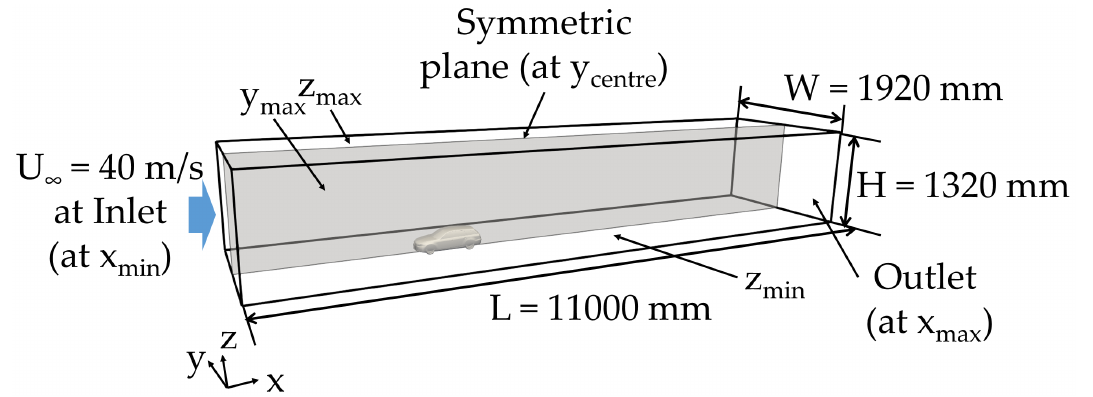
Figure 4. Schematic diagram of the computational domains.